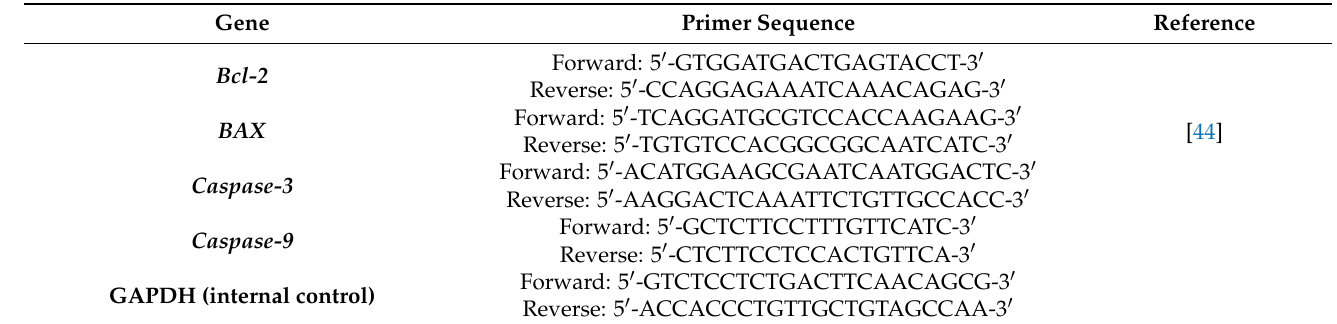
Table 2. List of primers used for the anti-cancer gene expression